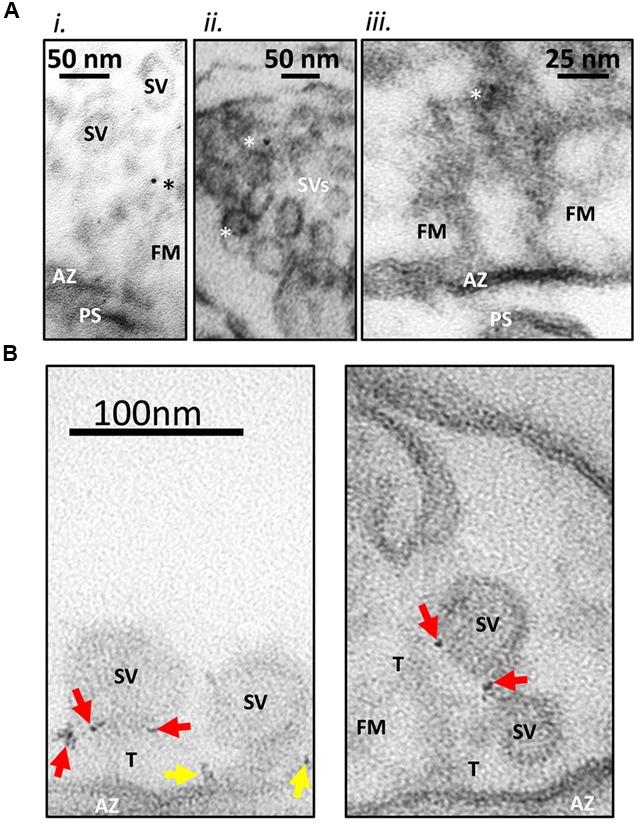
Immunogold labeling method. (A) Standard immunogold labeling method. Fresh synaptosomes were ruptured by osmotic shock, fixed and incubated with L4569, an anti-CaV2.2-C-terminal tip antibody. SSMs were prepared and sectioning for EM after exposure to colloidal gold (6 nm) conjugated secondary antibody. (i) Gold particle in the SV tether zone. (ii) Two SVs with associated gold in the peri-AZ region. (iii) Active zone (AZ) region of an SSM, opposing a short post-synaptic scab (PS) devoid of SVs but projecting fibrous material (FM; fibrous material linking the SV to the surface membrane are labeled as tethers, (T). Three dark spots were identified as a triplet of gold particles. These are located in the fibrous net ∼75 nm from the AZ. The images suggest that gold particles are associated both with SVs and fibrous material near the AZ. Particles were rarely seen at the surface membrane. Ghosts were imaged at 300K×. Gold particles denoted with asterisks. (B) New nanogold cluster labeling method. SSM ghosts were cryoloaded with L45 antibody against the CaV2.2 C-terminal tail to facilitate access to the intra-ghost epitopes. The ghosts were then cryoloaded with the Nanogold®-tagged goat anti-rabbit Fab fragment secondary and were imaged as in (A) but at 500K×. The small gold particles were observed most often as small clusters (arrows) which greatly facilitated the localization of the primary antibody. In these examples the nanogold clusters are frequently associated with the tethered synaptic vesicles (SVs; red arrows) or the AZ surface membrane (yellow arrows). Other labels are as in (A).